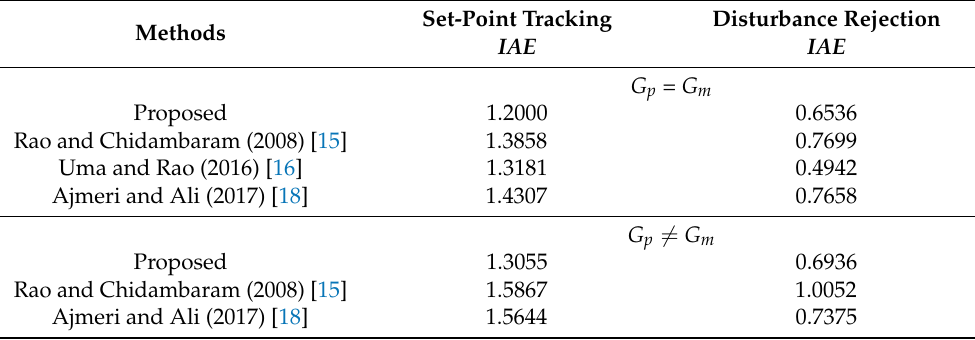
Table 3. IAE performance measures for Example 1.